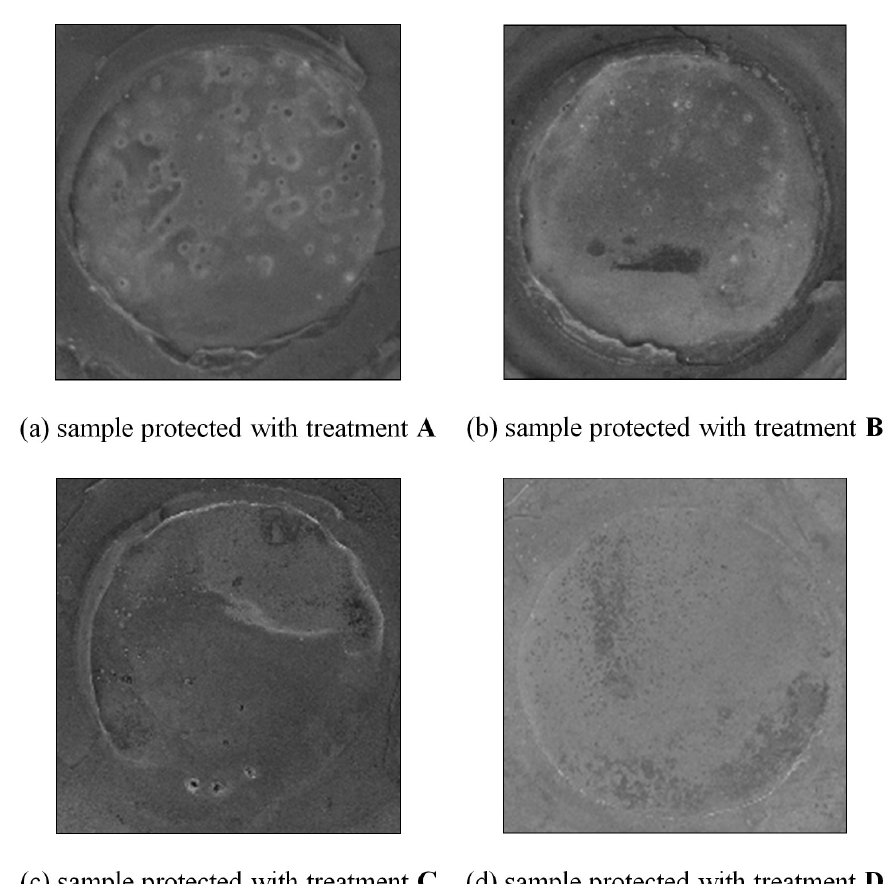
Figure 6. (a) Bode magnitude and (b) phase angle plots as a function of immersion time in aerated 0.3 mol.L –1 Na for Cr 6+ chromated electrogalvanised steel sample – sample protected with treatment